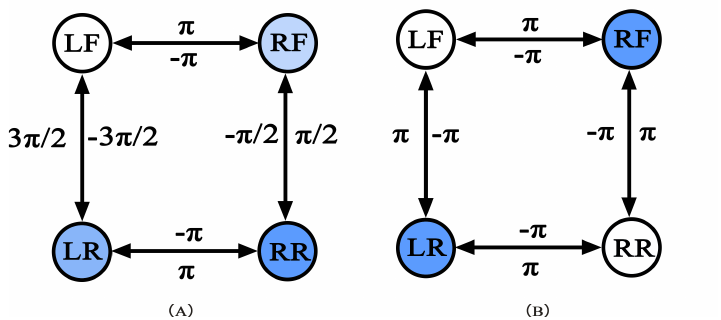
Figure 8. The control network of CPG in walk ( A ) and trot gait ( B